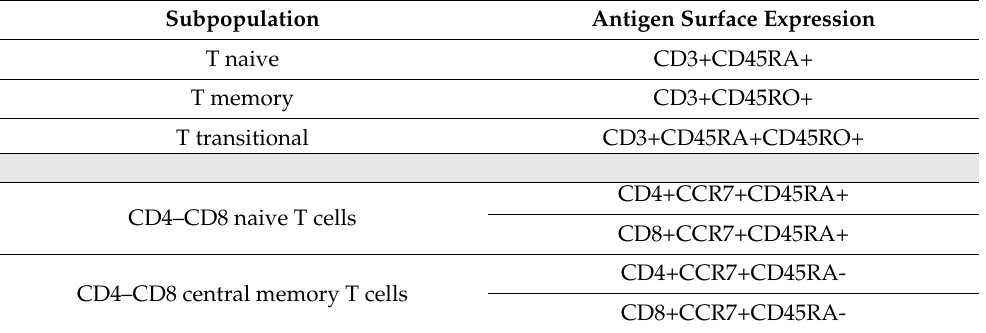
Table 1. Antigen surface expression considered for the definition of the T and B lymphocyte